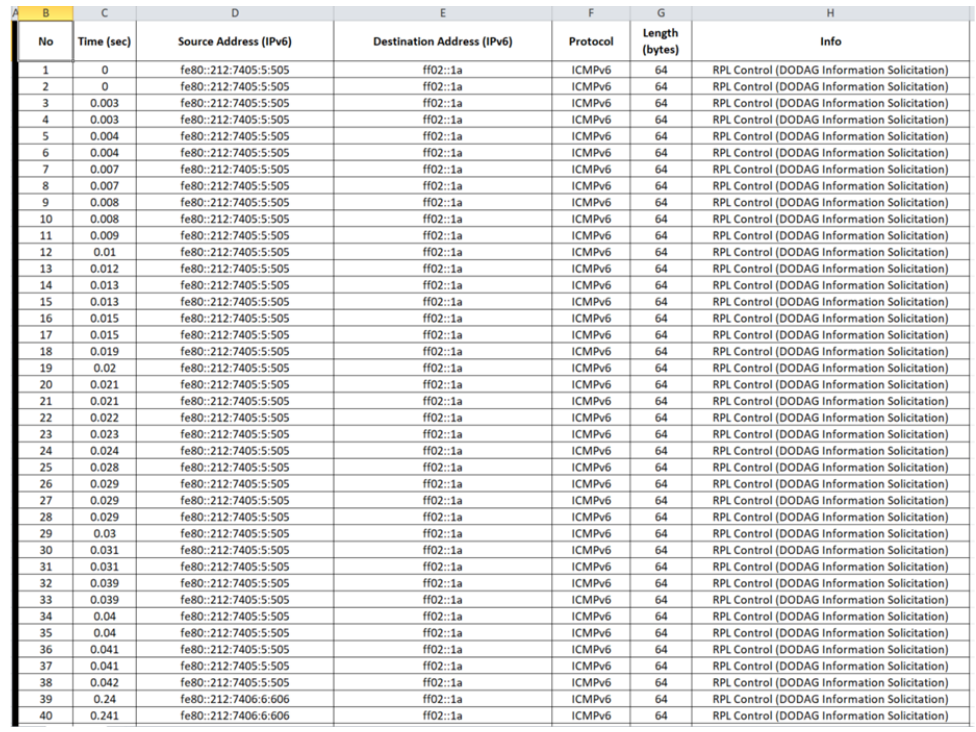
Figure 21. Benign “radiolog.csv”— 1 to 40 records.